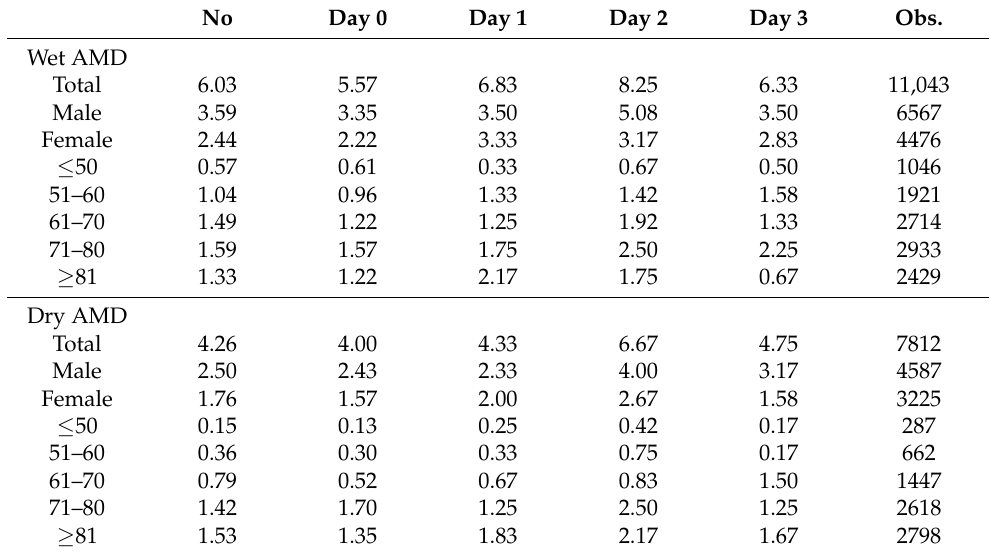
Table 1. Average daily AMD outpatient visits according to days after DSs stratified by gender and age. No Day 0 Day 1 Day 2 Day 3